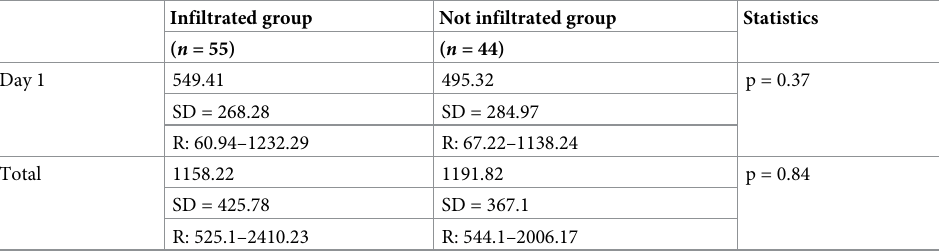
Table 6. Comparison of estimated blood loss in milliliters between